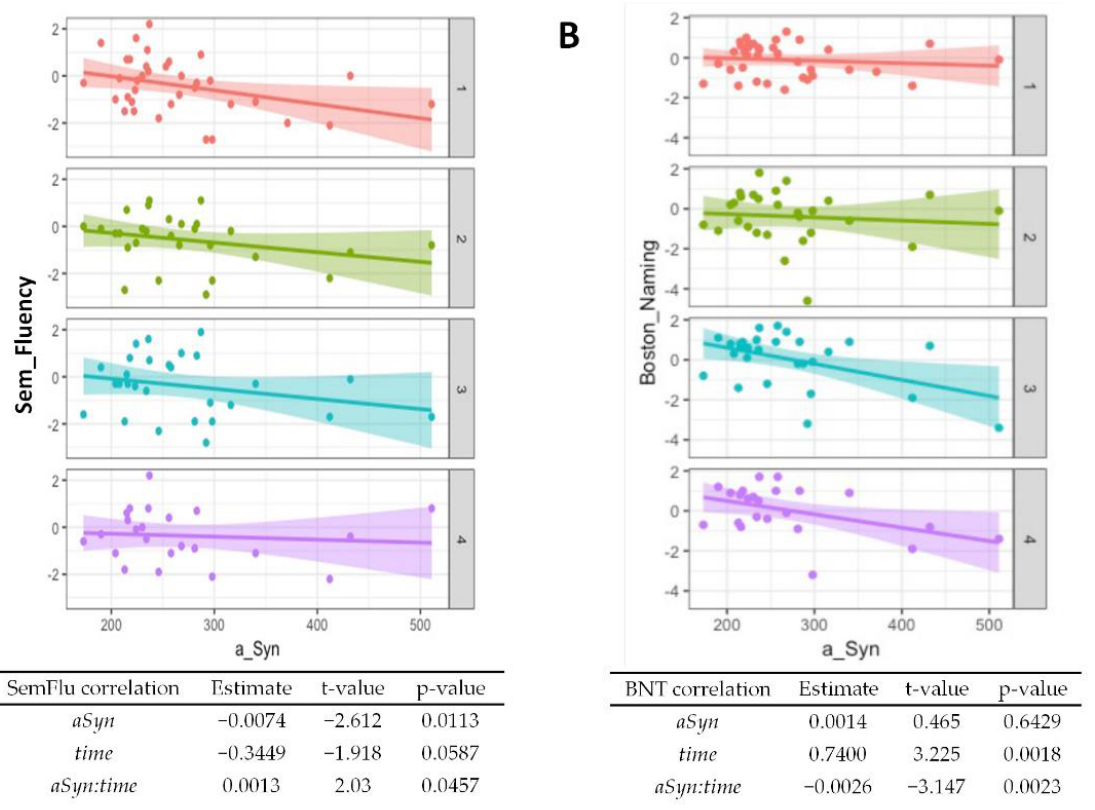
Figure 3. Association of α -synuclein with cognitive test performance. Correlations from mixed linear regression are displayed through scatter plots with regression lines at baseline (1, red plot), 6 months (2, green plot), 12 months (3, turquoise plot), and 24 months (4, purple plot). Estimates, t- values, and p -values refer to the correlation of results from the Boston Naming Test (BNT) ( A ), Se- mantic verbal fluency (SemFlu) ( B ), Trail Making Test A (TMT A) ( C ), and Trail Making Test B (TMT B) ( D ) with α -synuclein ( αSyn ), changes over time ( time ), and to the corre lation of baseline CSF α - synuclein with changes in stage/score over time ( αSyn:time ). 4. Discussion The model that explains the pathogenesis of PD by a deposition of misfolded α -synu- clein suggests that CSF α -synuclein may serve as a potential diagnostic and prognostic marker. However, the literature regarding α -synuclein and cognition is sparse and heter- ogeneous. There is neither an established uniform cognitive test battery nor a uniform